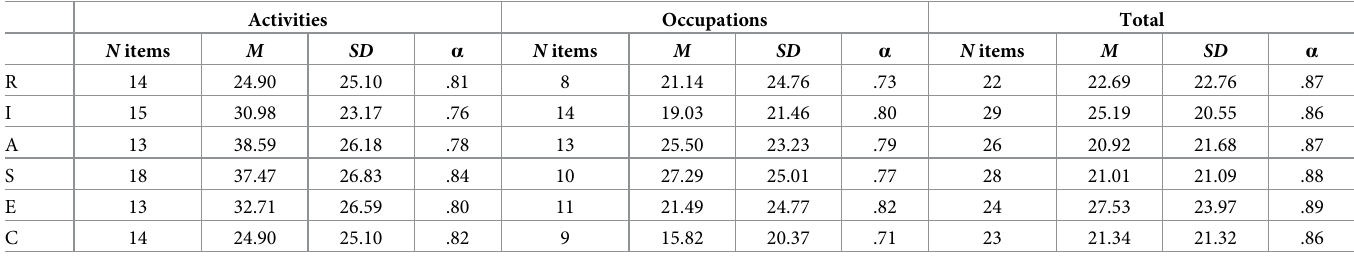
Table 1. Dimension descriptive statistics, internal consistencies and number of